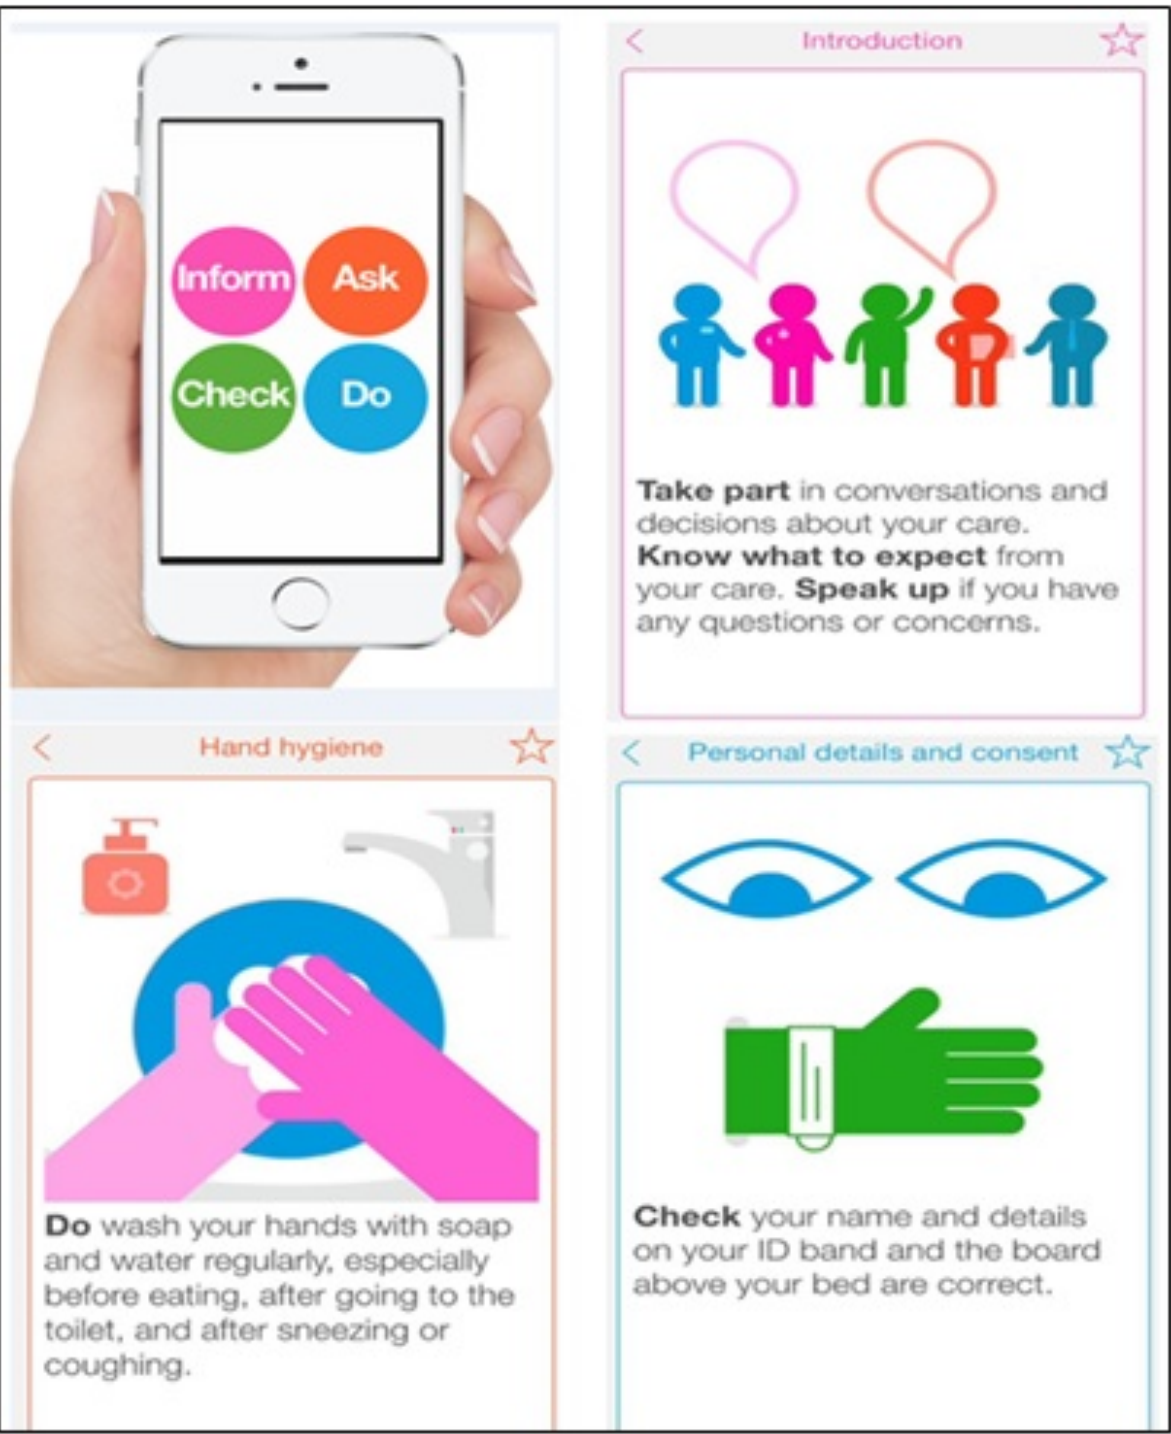
Figure 1. MySurgery app